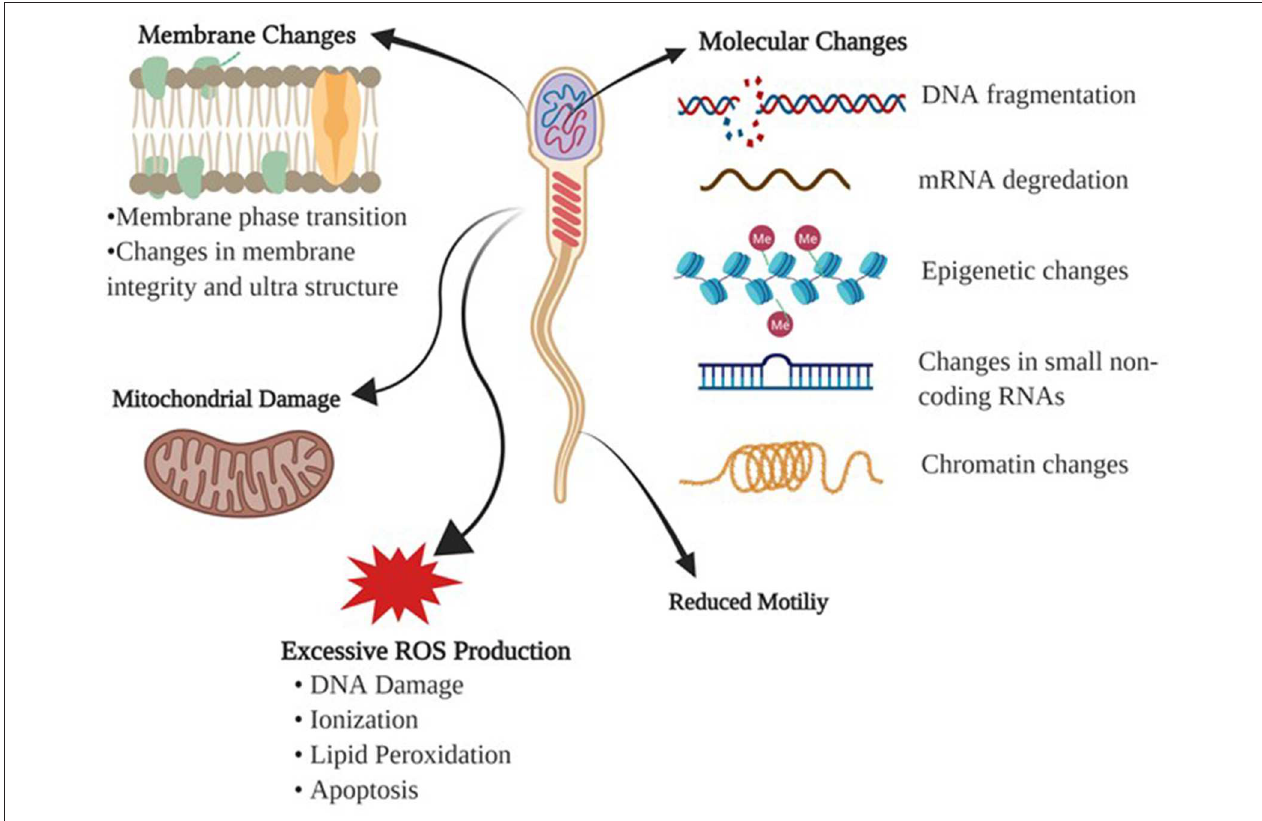
FIGURE 1 | Detrimental effects of freezing-thawing on a sperm cell. Morphological and physiological effects of freezing and thawing processes on bull sperm are